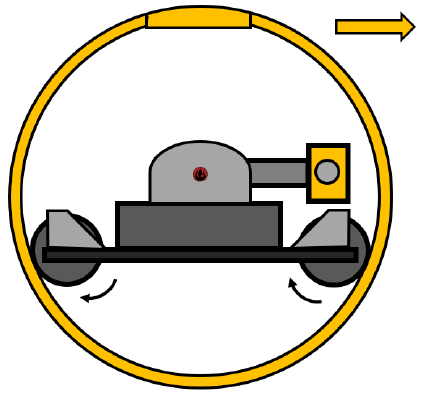
Figure 10. Principle sketch of our